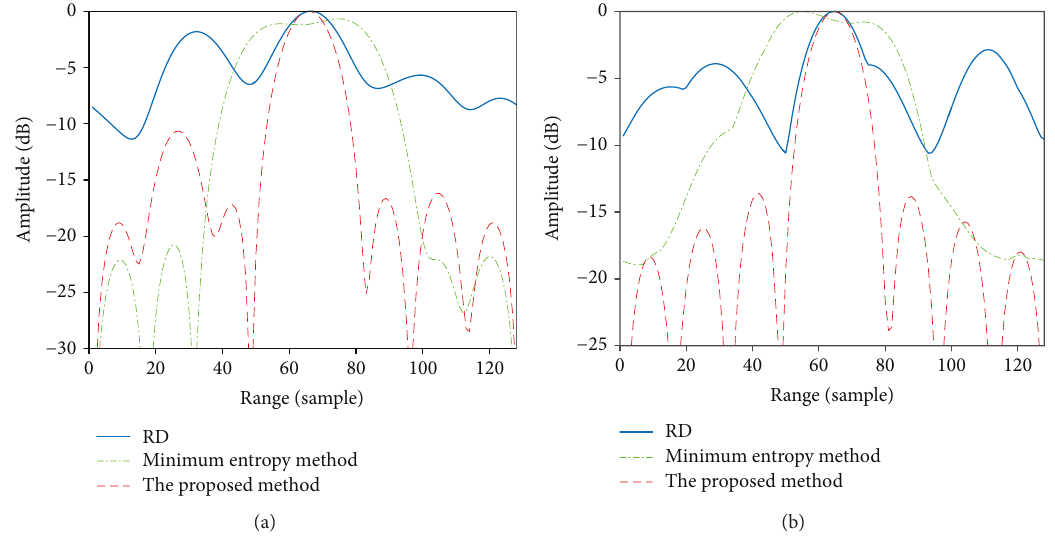
Figure 11: Pro fi le comparison of the scattering point marked by the red circle in Figure 10. (a) Comparison in range. (b) Comparison in azimuth.